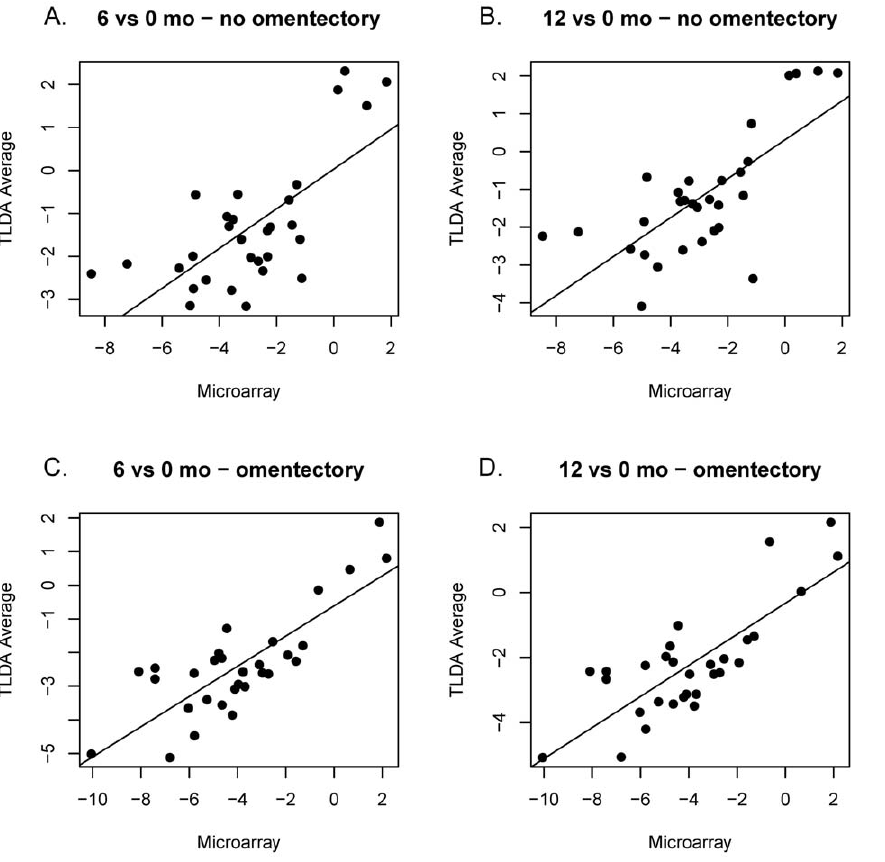
Figure 8. Correlation in fold change (log 2 ) of gene expression as determined by Affymetrix Exon microarray and TLDA profiling. A) 6 vs. 0 months, no omentectomy, Pearson correlation coefficient rho=0.559, p , 0.0001; B) 12 vs. 0 months, no omentectomy, Pearson correlation coefficient rho=0.646, p =0.0002; C) 6 vs. 0 months, yes omentectomy, Pearson correlation coefficient rho=0.649, p =0.0002; D) 12 vs. 0 months, yes omentectomy, Pearson correlation coefficient rho=0.640, p